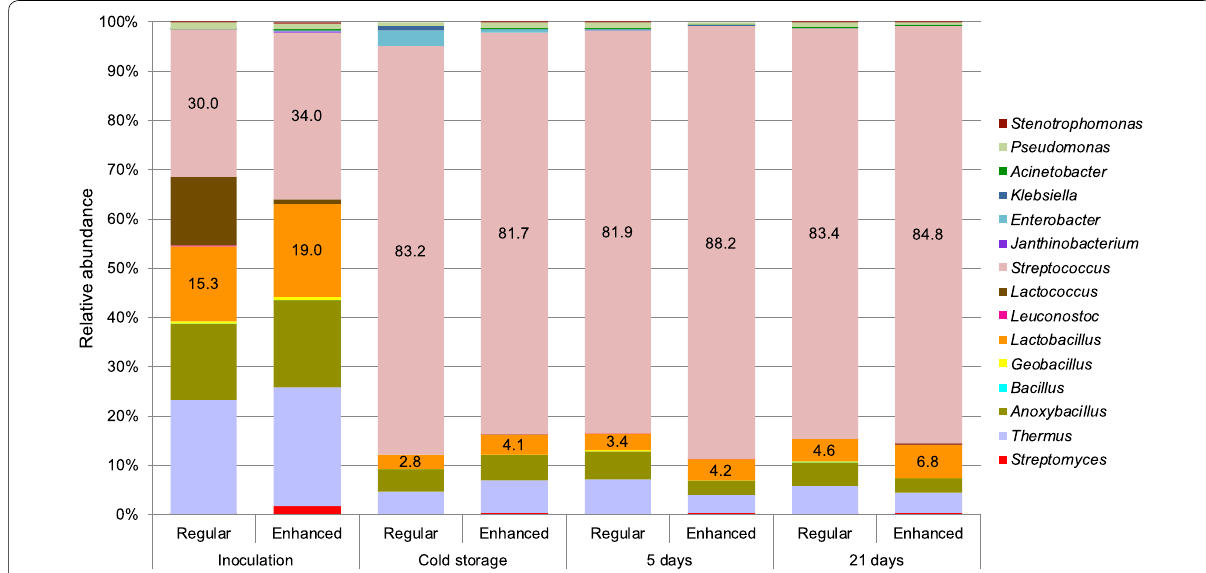
Fig. 1 Relative microbial abundance (%) in yoghurt produced using regular and sweetness-enhanced (enhanced) milk using the traditional YoFlex ® Premium 4.0 starter culture. The relative abundance of the starter culture genera ( Streptococcus and Lactobacillus ) are